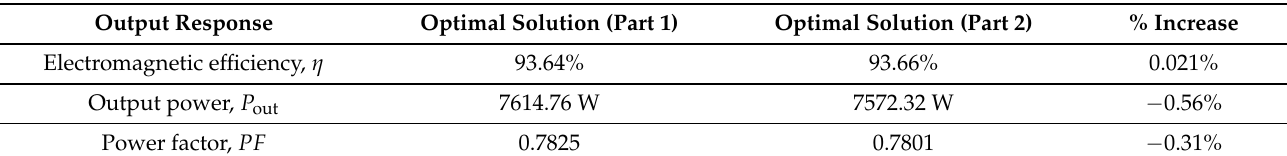
Table 7. Surrogate optimal solution compared with the improved optimal solution (part 1—surrogate optimization vs. part 2—pattern search) of the proposed optimization routine 3-variable optimization problem.